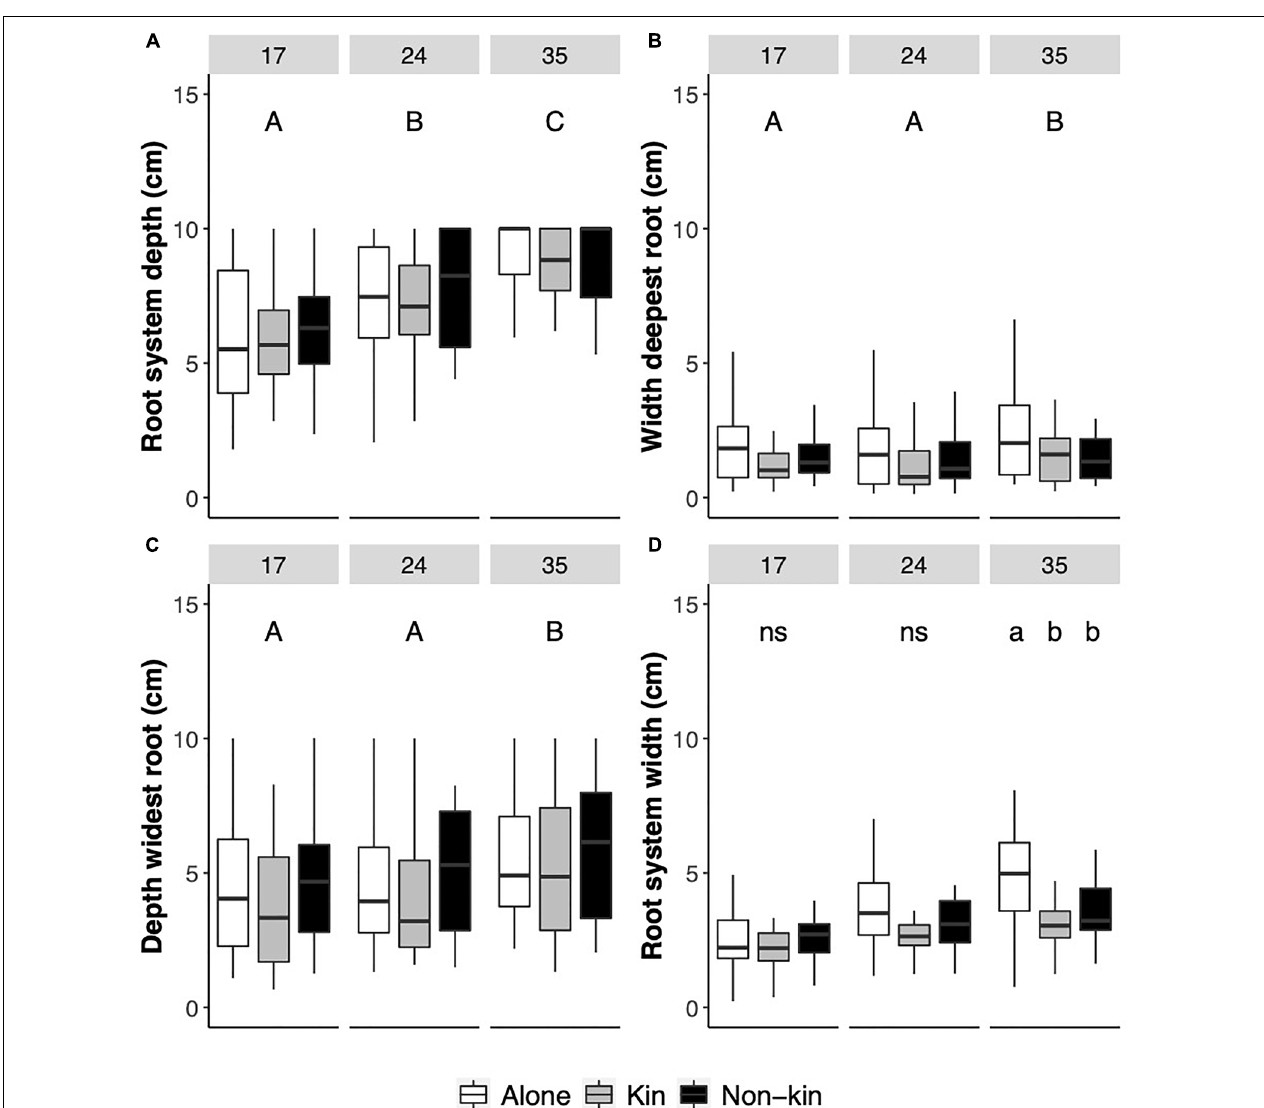
FIGURE 3 | Boxplots of (A) maximum root system depth (cm), (B) Width of the deepest root, (C) Depth of the widest root, and (D) maximum width of the root system of Glechoma hederacea plants grown alone (white boxes) or with a kin (gray boxes) or a non-kin plant (black boxes) measured after 17, 24, and 35 days in Experiment 1. Letters above bars indicate significant post-hoc